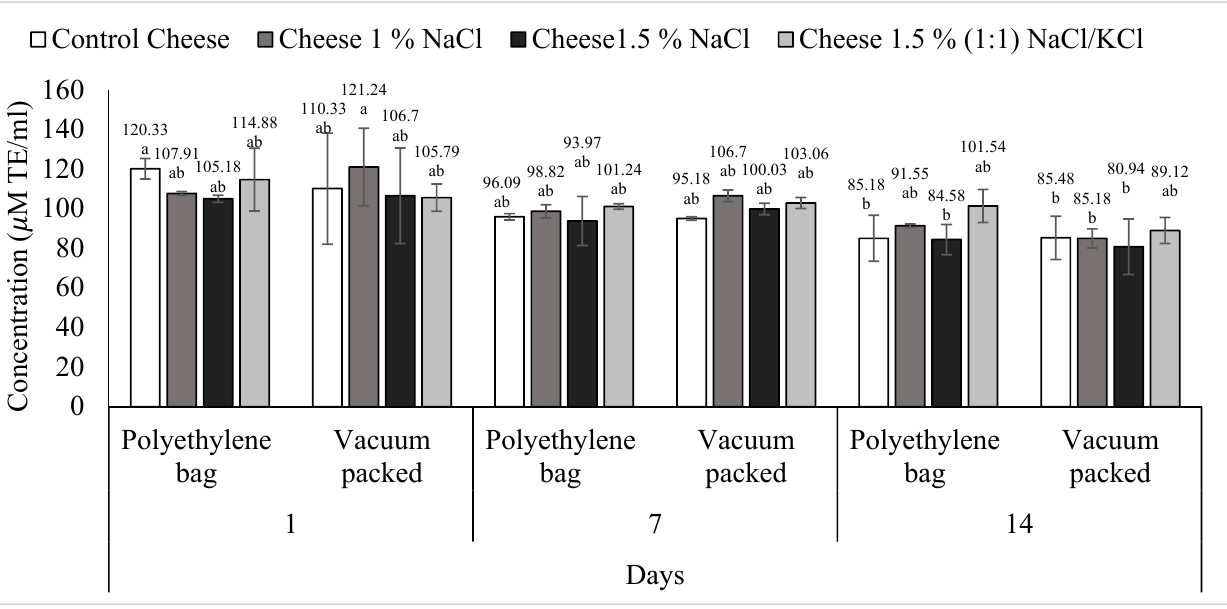
Figure 2. Antioxidant activity (DPPH˙ method) of requeson cheese with different salt type and concentration treatments, conventional and vacuum packaging. a,b Values with a different superscript indicate significant statistical difference ( p <